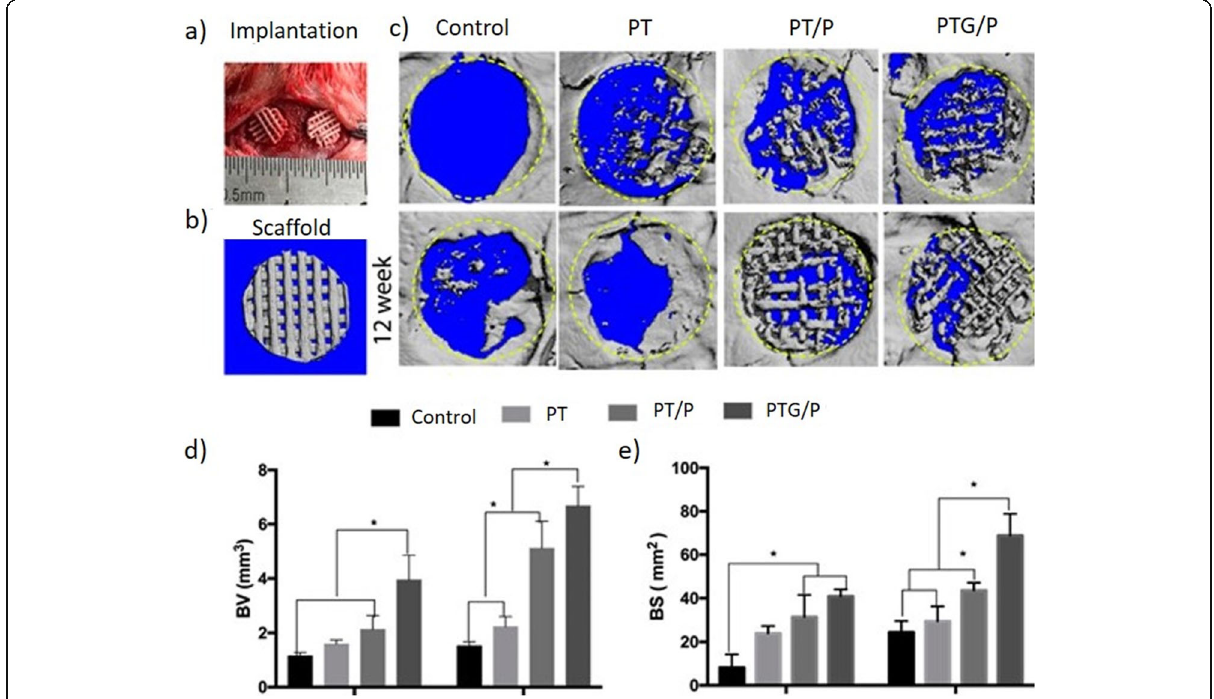
Fig. 12 Bone volume and bone surface results obtained by Micro-CT for the in vivo animal tests: a Implantation process; b Micro-CT image of the scaffold; c 3D reconstructed images of the control, PT, PT/P, and PTG/P scaffolds 4 weeks after the implantation (top row) and 12 weeks after the implantation (boot row); d Bone volume and e bone surface of the newly formed bone in the critical-size defects ( p < 0.05). Reproduced with permission from